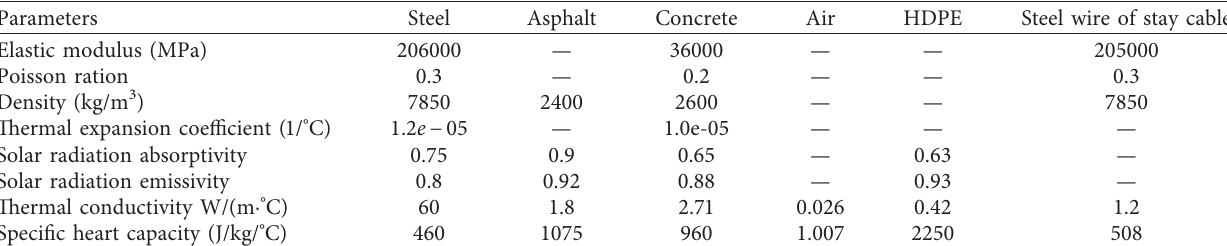
Table 1: Material mechanics parameters.